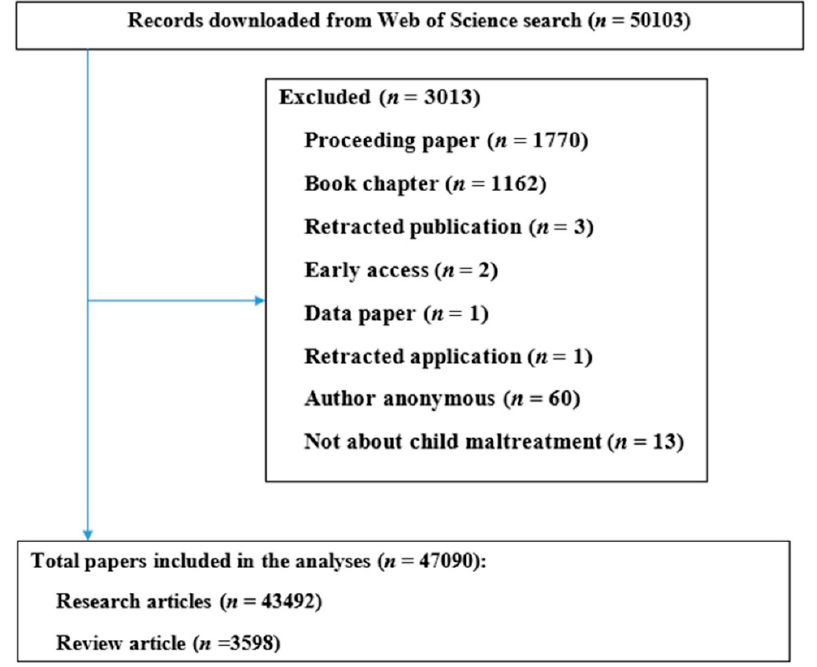
Figure 1. Selection of papers.